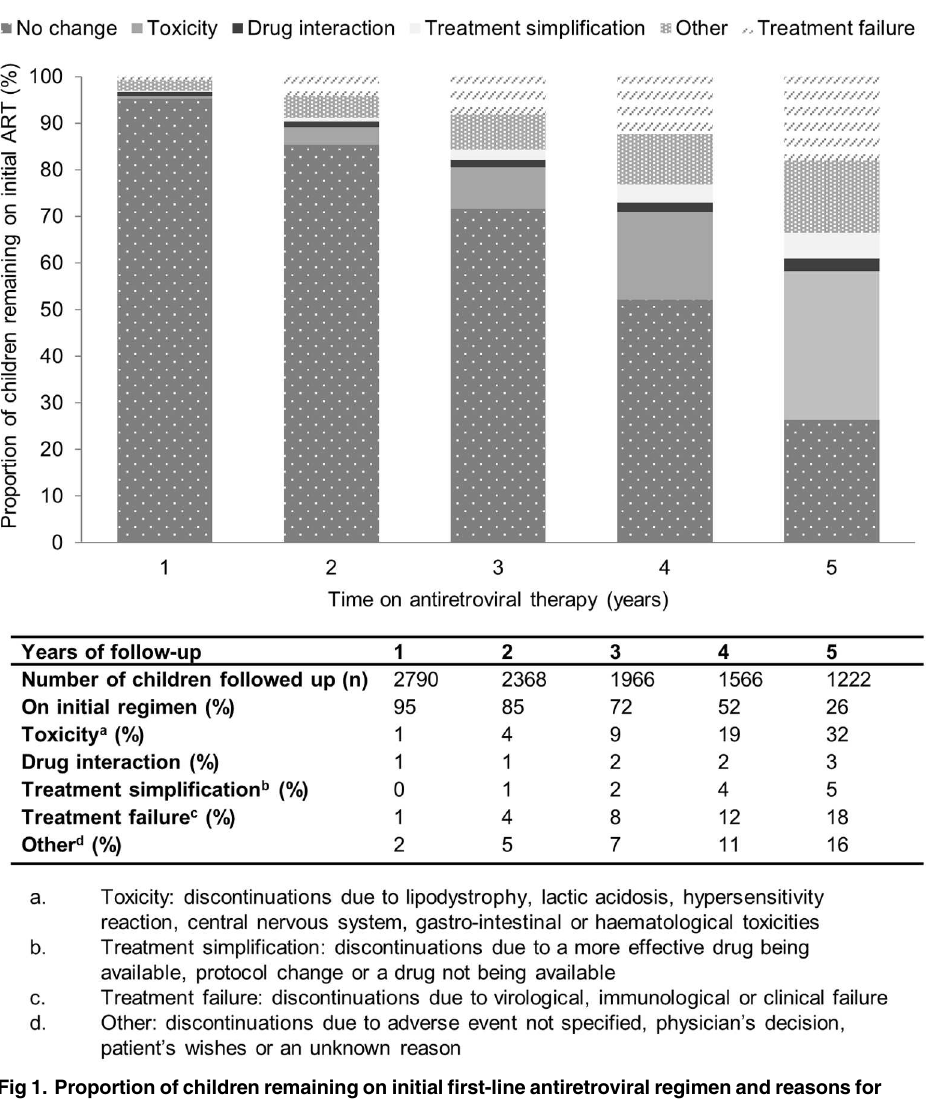
Fig 1. Proportion of children remaining on initial first-line antiretroviral regimen and reasons for regimen change over 5 yearsof follow-up.